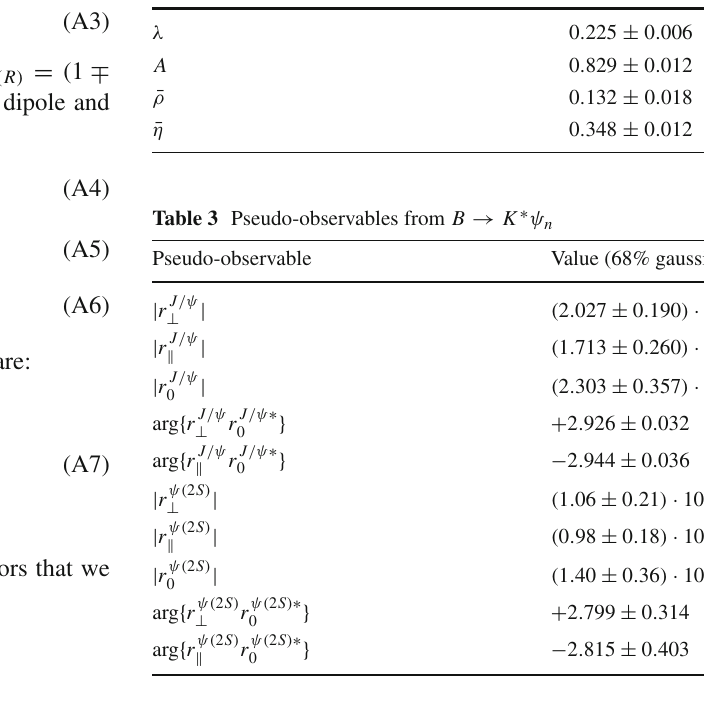
Table 2 Uncorrelated priors for the CKM parameters in our analysis, taken from the tree-level-only fit in Ref. [50] Parameter